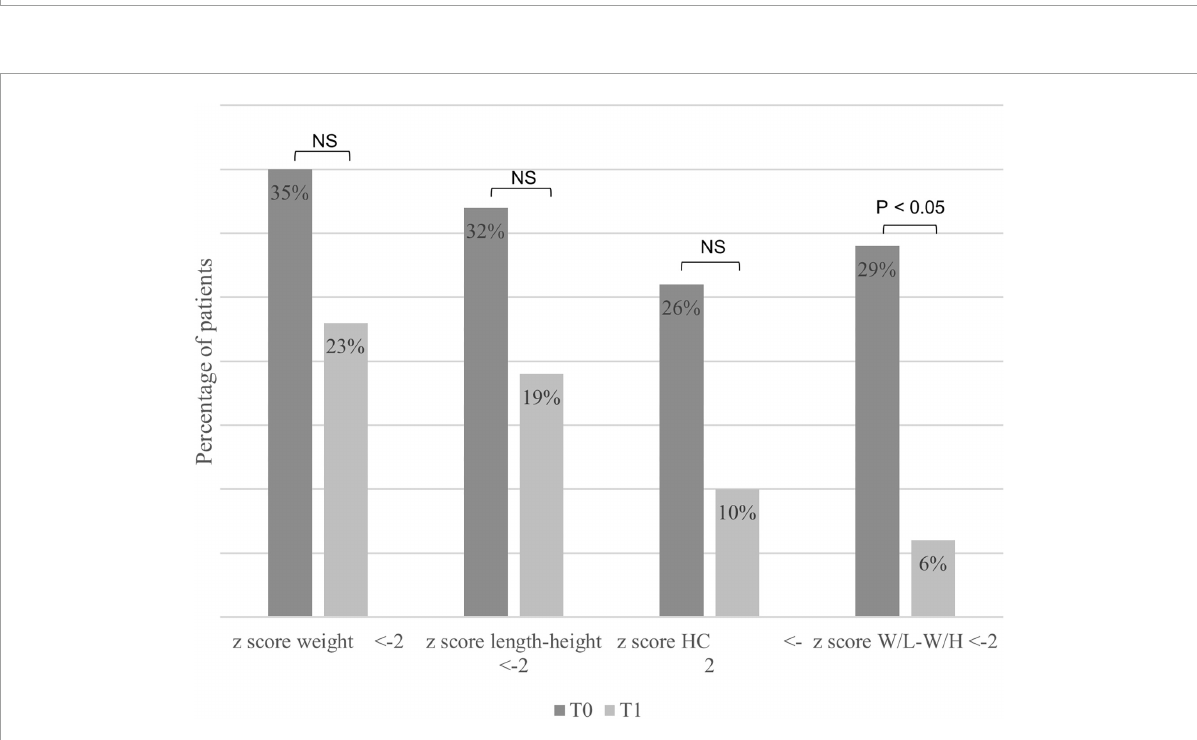
FIGURE3 Percentage of patients with a z score < –2 for anthropometric parameters at the start (T0) and the end (T1) of enteral nutrition. HC, head circumference; W/L, weight for length; W/H, weight for height; NS, not